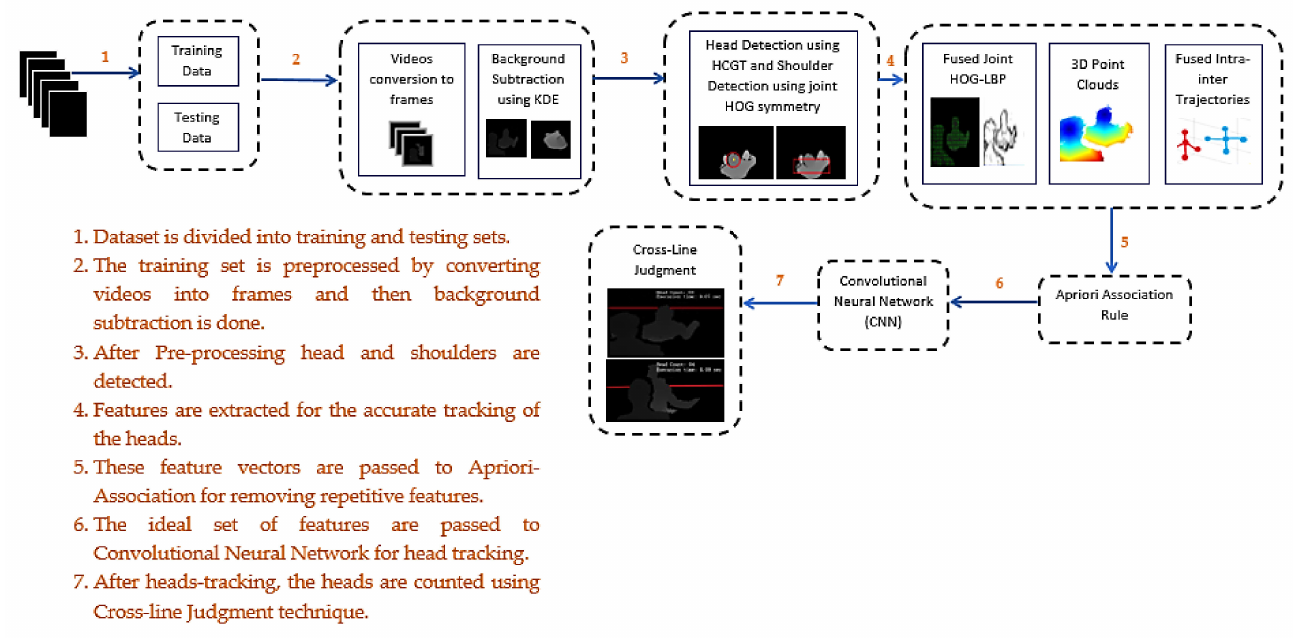
Figure 1. System architecture of the proposed HASTAC